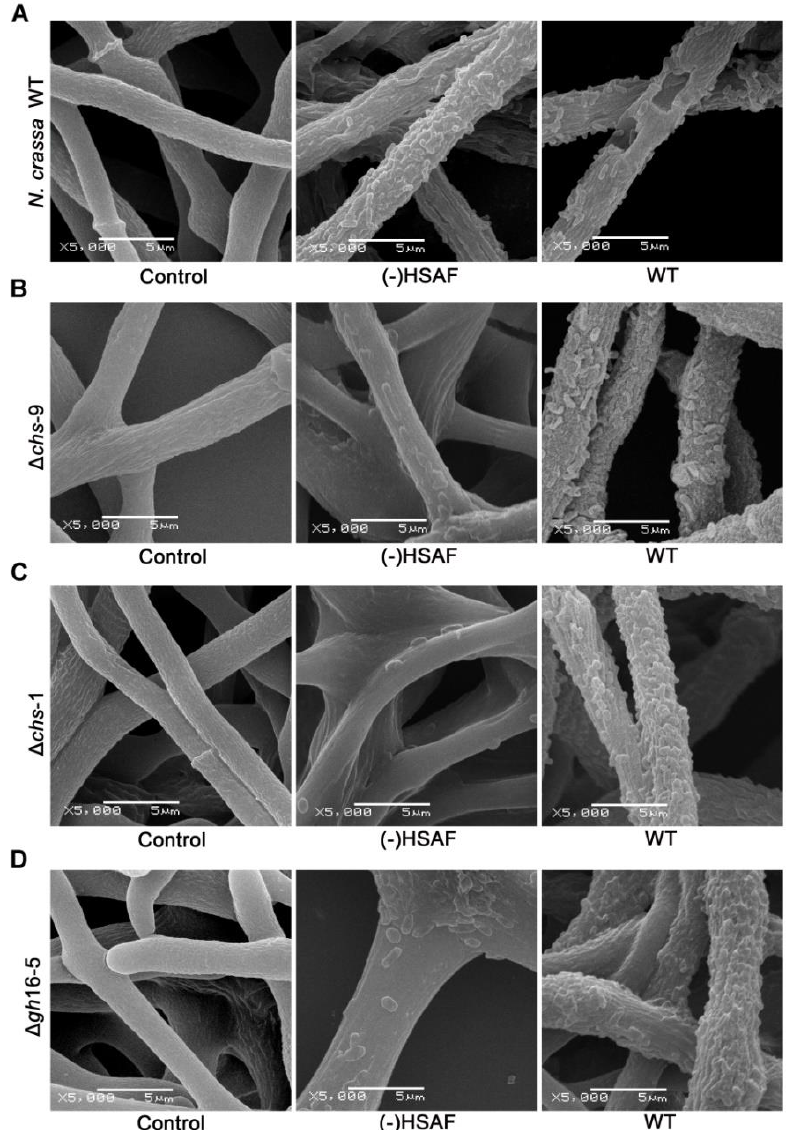
Figure 5. Physical interactions between different L. enzymogenes mutants and N. crassa mutants. ( A ) N. crassa WT; ( B ) N. crassa ∆ chs -9 mutant; ( C ) N. crassa ∆ chs -1 mutant; ( D ) N. crassa ∆ gh16-5 mutant interacted with L. enzymogenes strains . Control indicates growth of N. crassa alone, WT indicates L. enzymogenes wildtype strain and (-)HSAF indicates no-producing HSAF L. enzymogenes strain. Images show the results of one out of three replicates.